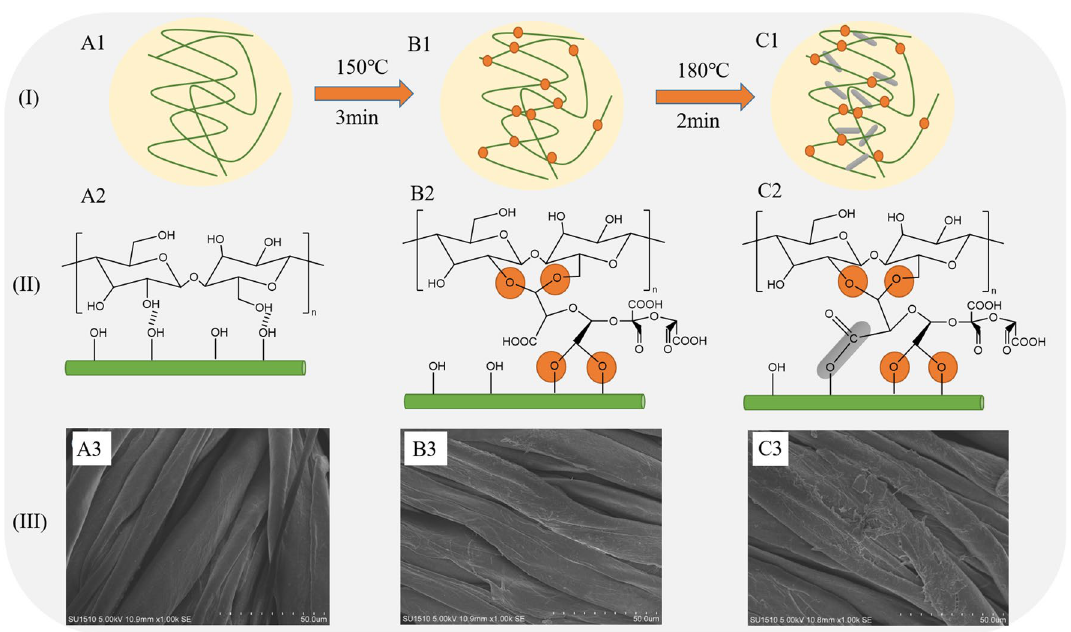
Figure 7. Possible reaction mechanism (I, II), SEM images (III) of reference (A1, A2, A3), openSu (150 °C) (B1, B2, B3) and openSu (150 °C and 180 °C) (C1, C2,